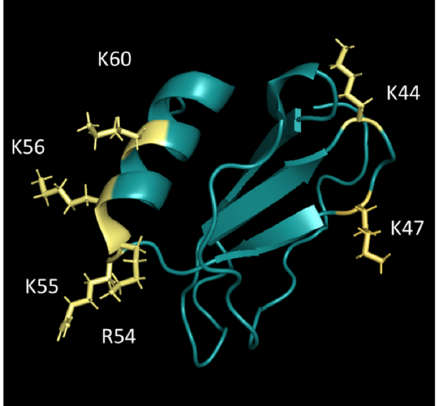
Figure 3 . Design of GAG ‐ binding knock ‐ out alanine mutants of CCL26 (pyMOL.org); positively charged amino acids (K47A, K44A, R54A, K55A, K56A, and K60A) that have been replaced by ala ‐ nine are highlighted in yellow